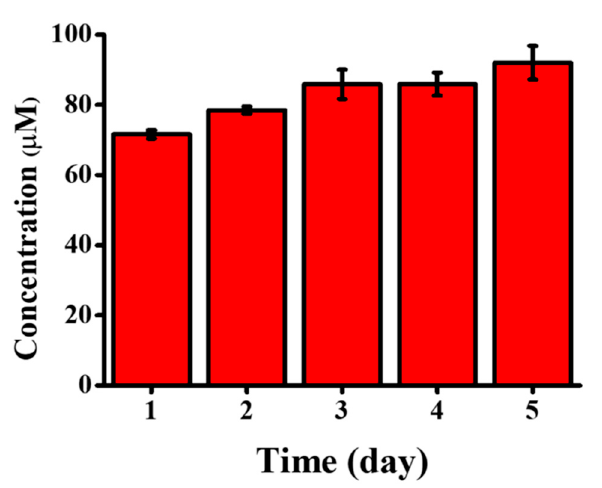
Figure 6. The Xan evolution in largemouth bass over 5 days of storage at 30 °C.